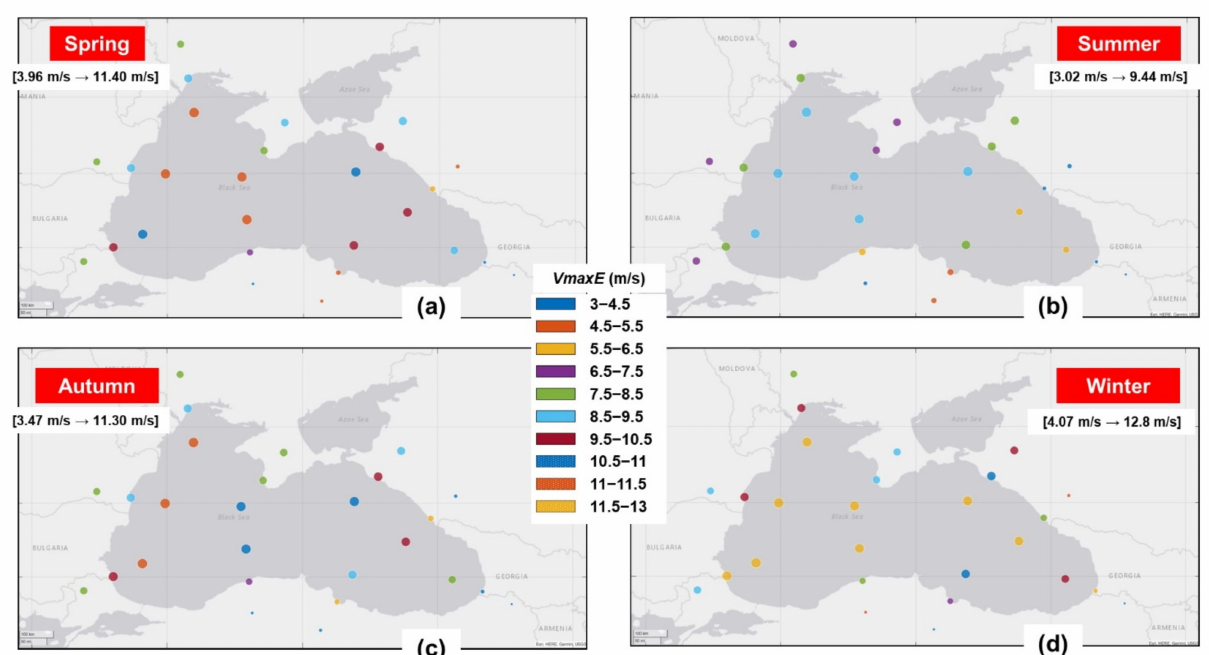
Figure 8. Seasonal distribution of the V maxE indicator (in m/s) based on the U 100 input, where: ( a ) spring; ( b ) summer; ( c ) autumn; ( d ) winter. The numbers from the square brackets indicate the minimum and maximum values related to each